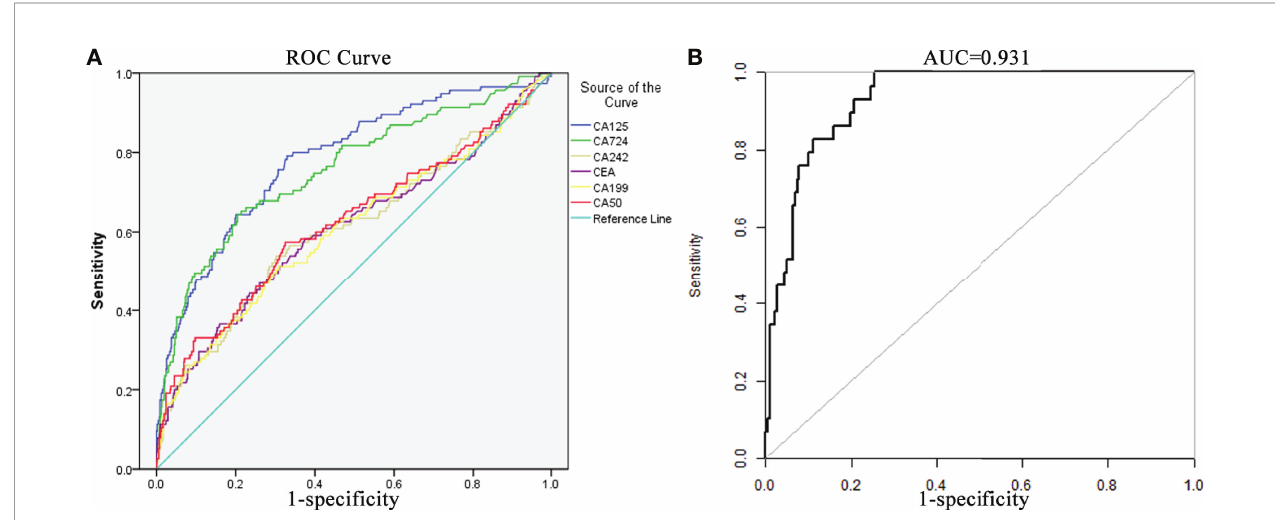
FIGURE 2 | Receiver operating curve (ROC) curves of independent risk factors. (A) ROC curve of the important risk factors, including 6 serum tumor markers (CA125, CA724, CA242, CEA, CA199 and CA50). (B) ROC curve of the multivariate logistic regression model (AUC of the curve was 0.931, 95% CI: 0.900 –